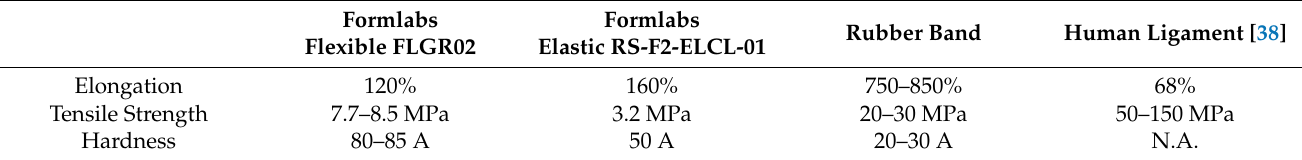
Figure 3. Our robotic hand joint and ligament. Table 2. Comparison of 3D-printed materials and a rubber band.